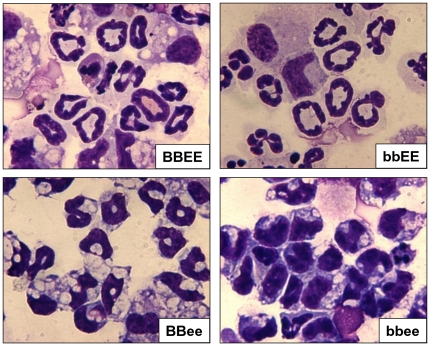
Morphological characterization of neutrophils harvested by lavage from peritoneal cavity. Wild-type, C/EBPβ−/− (bbEE), C/EBPε−/− (BBee) and C/EBPβ−/−C/EBPε−/− (bbee) mice were injected with 1.5 mL of 4% thioglycollate into their peritoneal cavity. After 18 h, neutrophils were harvested by lavage. Cytopreps of cells were stained with Diff-Quick.